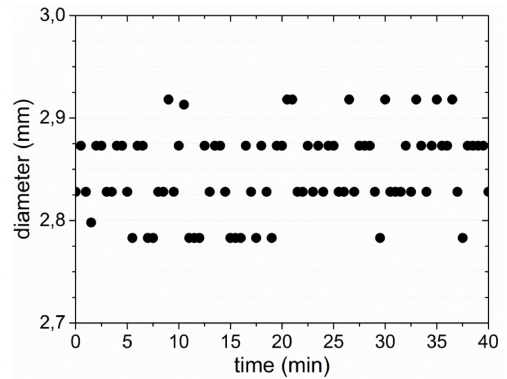
Figure 4. Evolution of filament diameter over time when extruding PEU. The development in measured values is also representative for an experiment in which Irgazin ® Red DPP BO was added during extrusion of PEU.